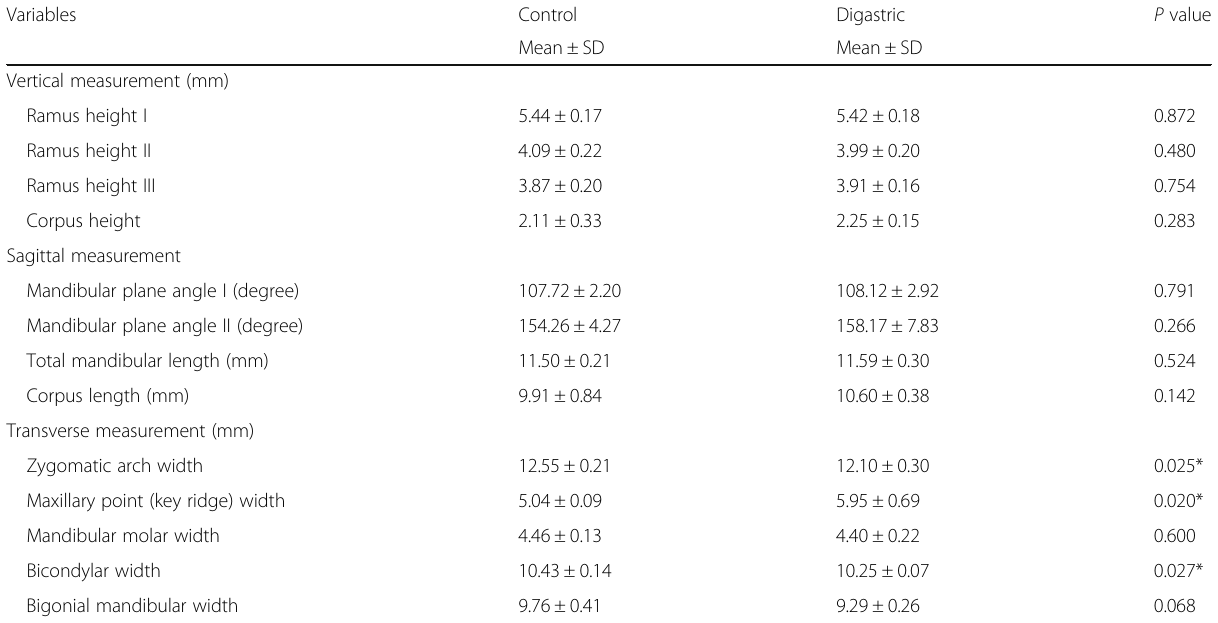
Table 1 Comparison of the anthropometric measurement of the maxillofacial bone in control and experimental group